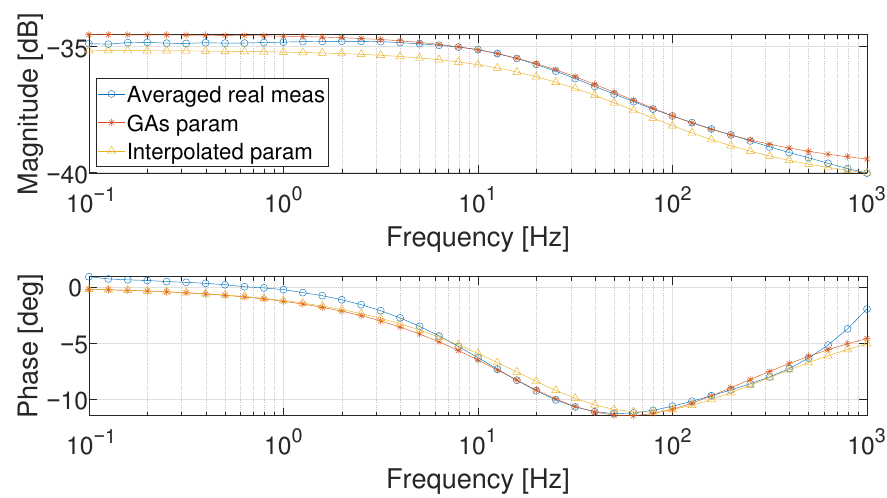
Figure 22. Bode diagram of the averaged real measurements (circle marked), of the identified model (asterisk marked) and the model with the interpolated parameters at